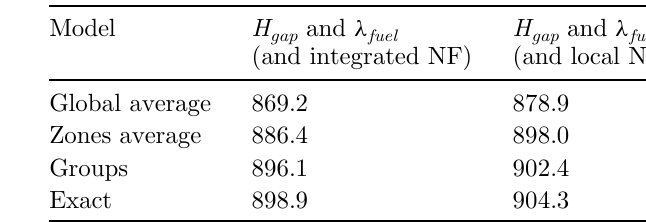
Table 2. Comparisons of sodium maximal temperature ( ° C) during ULOF/PP accident with and without local neutronic feedbacks.